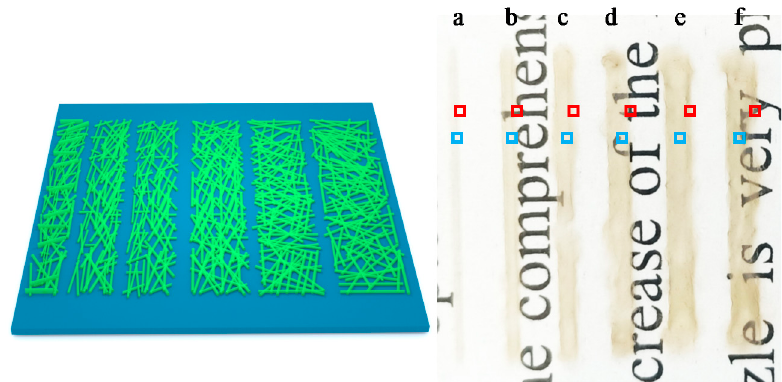
Figure 11. Designed patterns with lengths of 20, and widths of 500 µm and different printed layers ( left ), photographs of printed patterns ( right ) with 200 (curve a), 500 (curve b), 800 (curve c), 1100 (curve d), 1400 (curve e), and 1700 µm (curve f) after heat treatment.